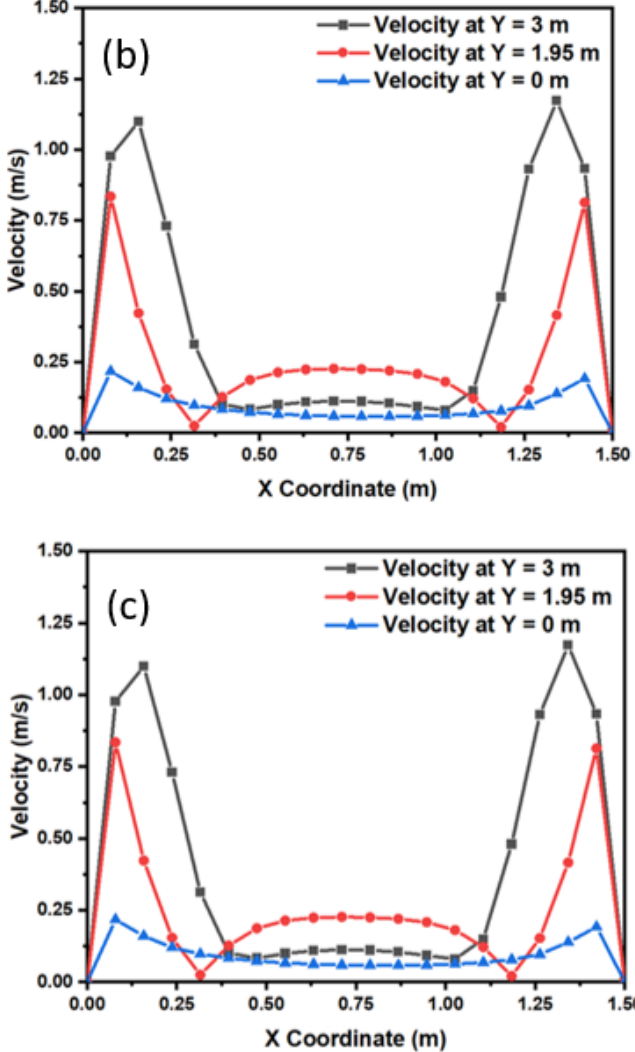
Figure 7. The inclusion velocity profile in the mold at 1853 K; size: ( a ) 5 microns, ( b ) 100 microns, and ( c ) 300 microns.